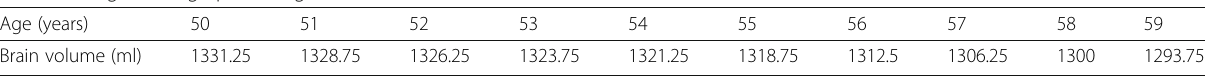
Table 1 Showing an age range sample (50 – 59 years) of the relation between the age in years and the whole brain volume (WBV) in ml according to the graph of Virginia institute (Ross et al. 2016)14